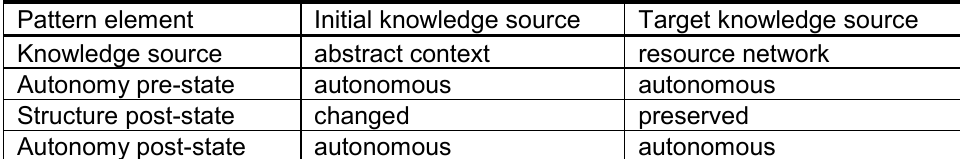
Table 4. Configured fusion (the main pattern)